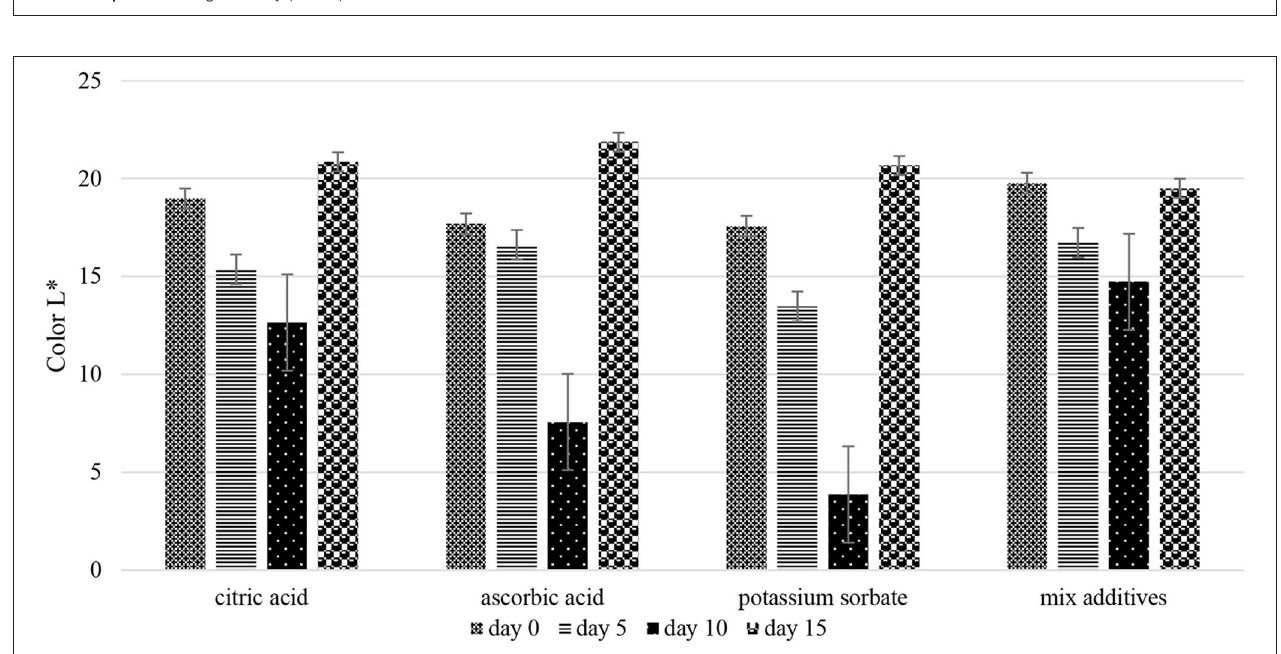
FIGURE 4 | AVG coating color